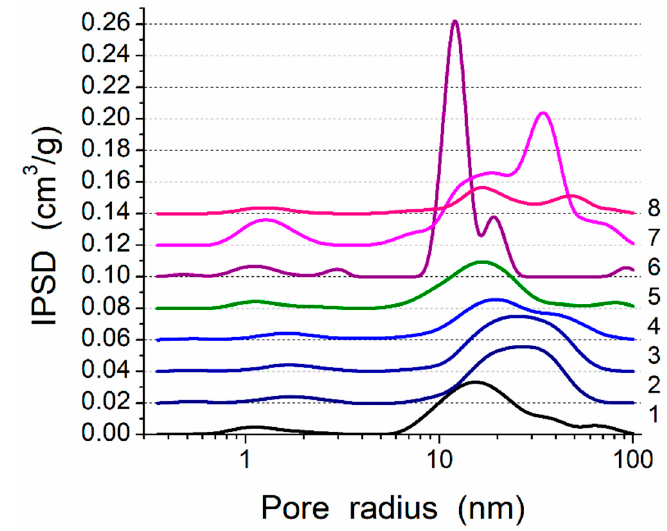
Figure 3. Incremental pore-size distributions (PSD) (SCV/SCR method) for PMS, A-300 and their blends (curve numbers correspond to sample numbers in Table 1).